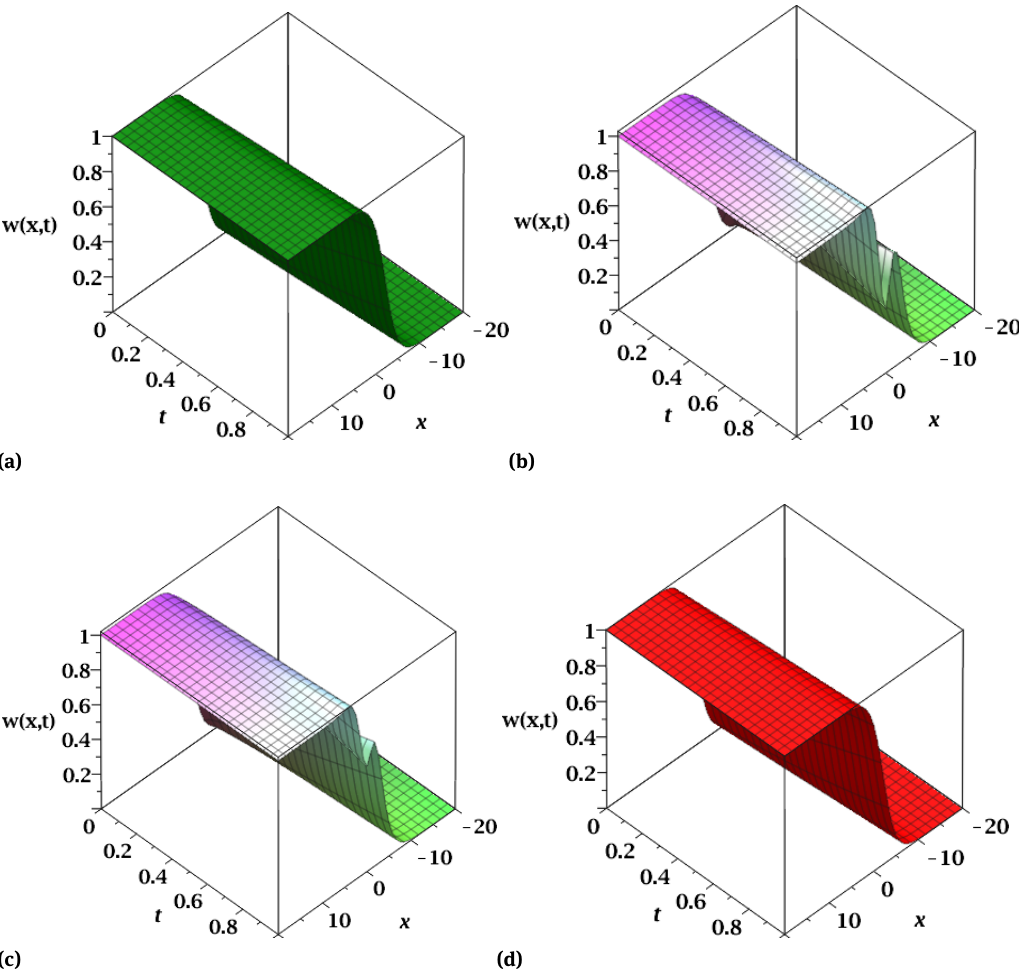
Fig. 1: (a) Exact solution when ρ = −1, for Ex. 5.1; (b) Numerical simulation of w ( x , t ) at β = 0.25 when ρ = −1, for Ex. 5.1; (c)Numerical simulation of w ( x , t ) at β = 0.50 when ρ = −1, for Ex. 5.1; (d) Numerical simulation of w ( x , t ) at β = 1 when ρ = −1, for Ex. 5.1